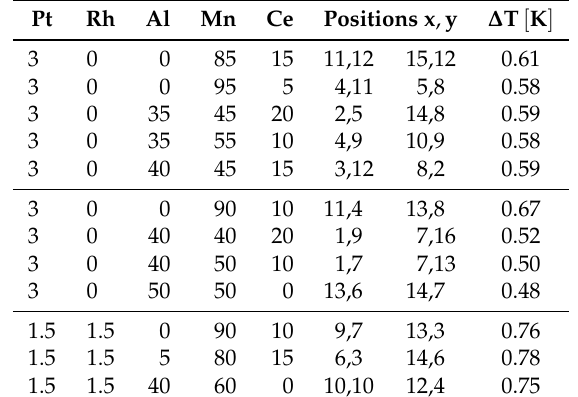
Figure 8. Average ∆ T values for samples from composition spread library 2 with given composition, measured using ecIRT. Axis labels denoting the mole fraction χ of given element as percentage, e.g., Al representing χ Al = n Al , PM are excluded from this calculation. Sample compositions are n Al + n Mn + n Ce displayed by a dot and values between dots are generated using linear interpolation. Table 2. Compositions of most promising materials from Figure 8, position on slate library 2, and average ∆ T